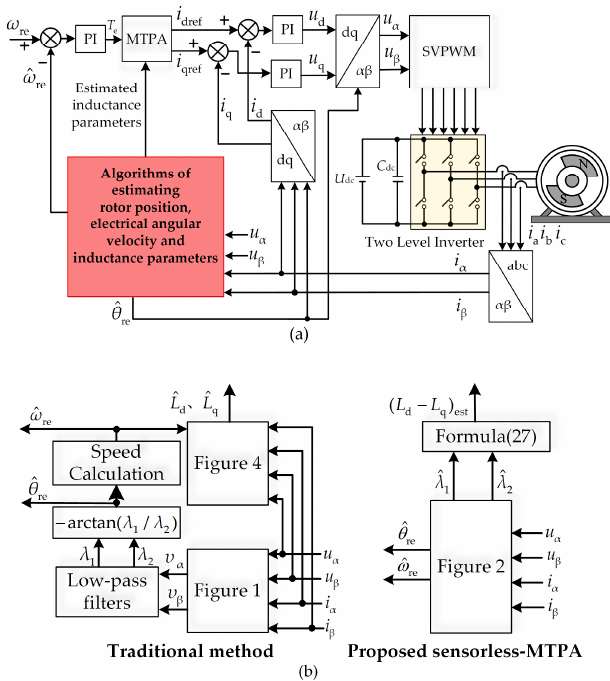
Figure 3. Control block diagram of maximum torque per ampere (MTPA) control for interior